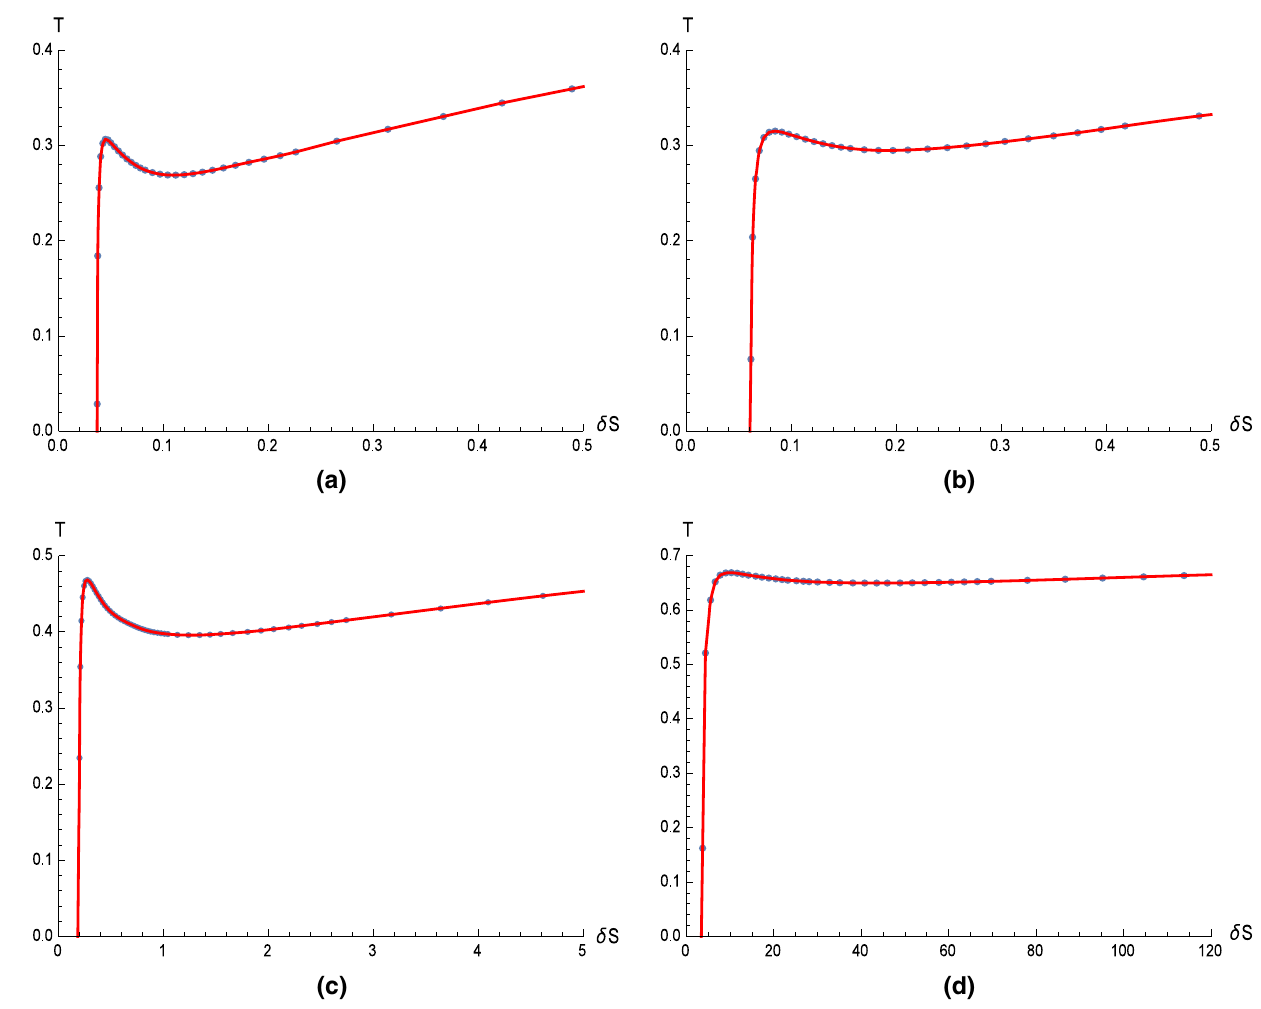
Fig. 9 T vs. δ S for n = 3 ,θ 0 = 0 . 3. a α = 0 , q = 0 . 12, b α = 0 . 25 , q = 0 . 12, c α = 0 . 5 , q = 0 . 06, d α = 0 . 75 , q = 0 . 06